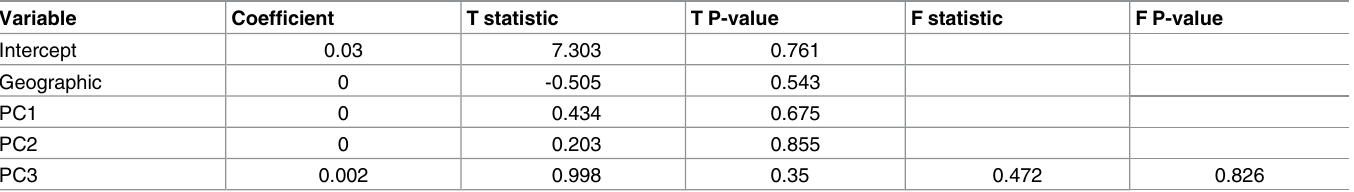
Table 2. Results of the Multiple Matrix Regression with Randomization (MMRR) analyses, which tests whether geographic and environmental dis- similarity influence genetic differentiation among populations, were not significant. PC axes were obtainedfrom a PCA analysisof 19 Bioclim vari- ables [39]. Variableswere orderedby significancein the model (T